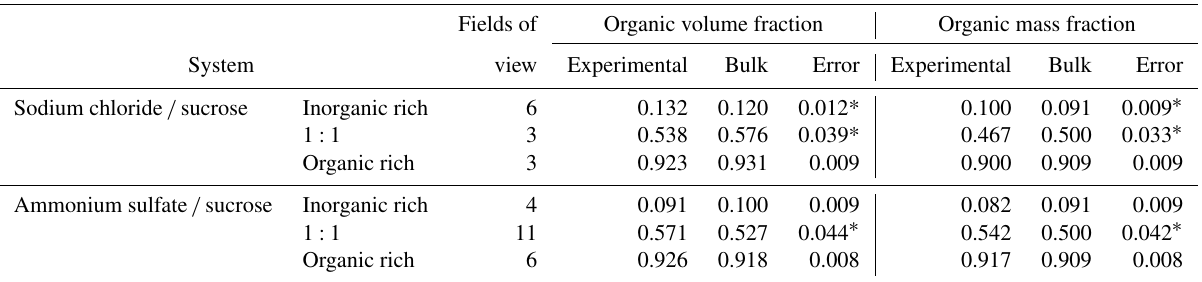
Table 2. Experimental and bulk values for organic volume fraction and organic mass fraction along with their associated absolute error (Relative errors for OVF and OMF are identical to within rounding). Errors with an asterisk cannot be attributed to statistics (95% confidence) alone. Fields of Organic volume